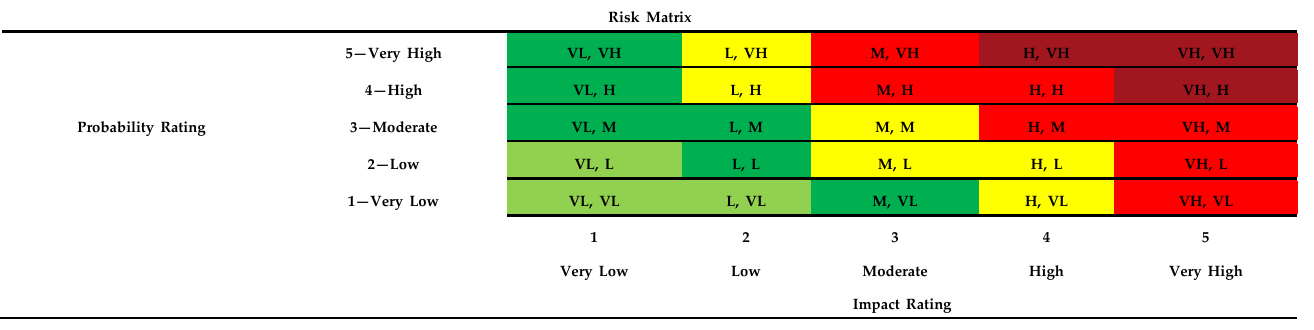
Figure 3. The risk matrix includes five zones